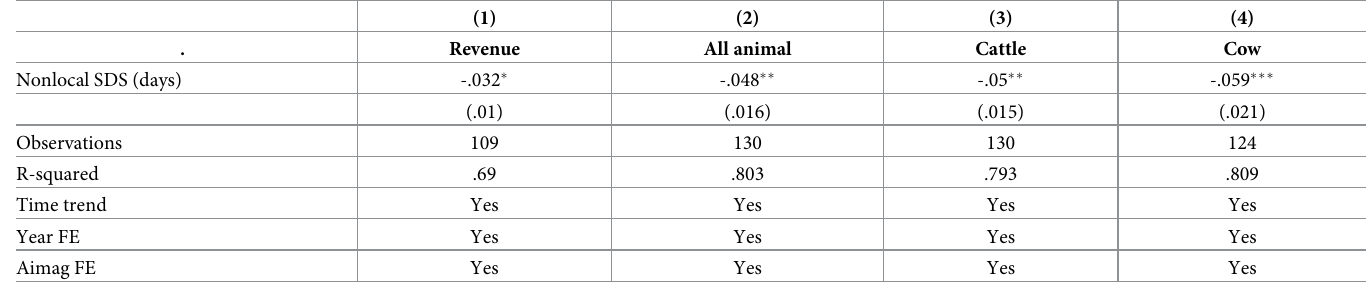
Table 5. Impact of sand and dust storms on livestock revenues and